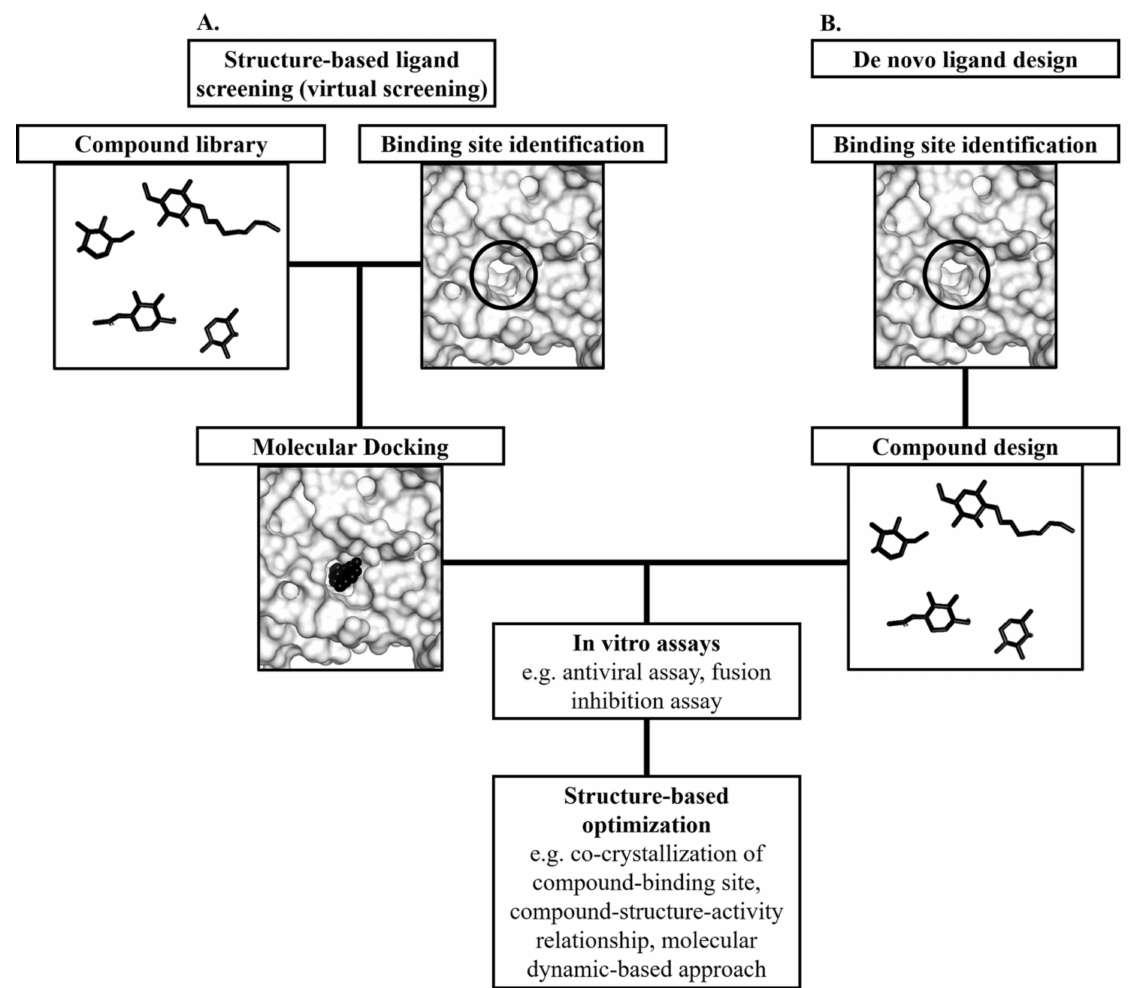
Figure 6. Structure-based dengue antiviral design. There are two approaches in structure-based antiviral design which are the structure-based ligand screening and the de novo ligand design. ( A ) In the structure-based ligand screening (virtual screening), molecular docking will be performed to identify compounds that can bind to the target binding site (circled). Thereafter, the compound hits will be assessed through in vitro assays such as antiviral assay. ( B ) In the de novo ligand design, compounds will be designed computationally to fit the target binding site (circled). Thereafter, in vitro assays will be performed to evaluate the antiviral activities of the compounds. Both approaches often require structure-based optimization to improve druggability and e ffi